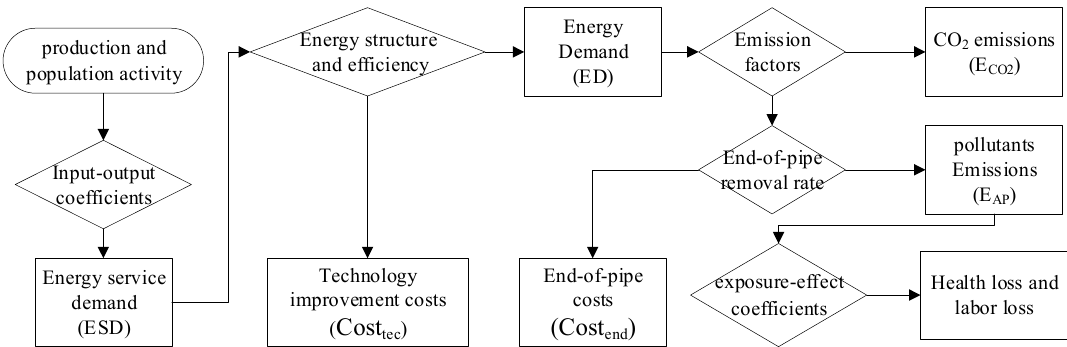
Figure 2. A brief data flow of the MCEE model.